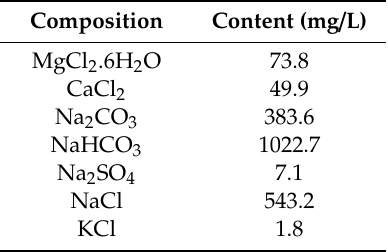
Figure 3. Microstructure of 3Cr steel. Table 1. Chemical composition of formation water drawn from the oil field.